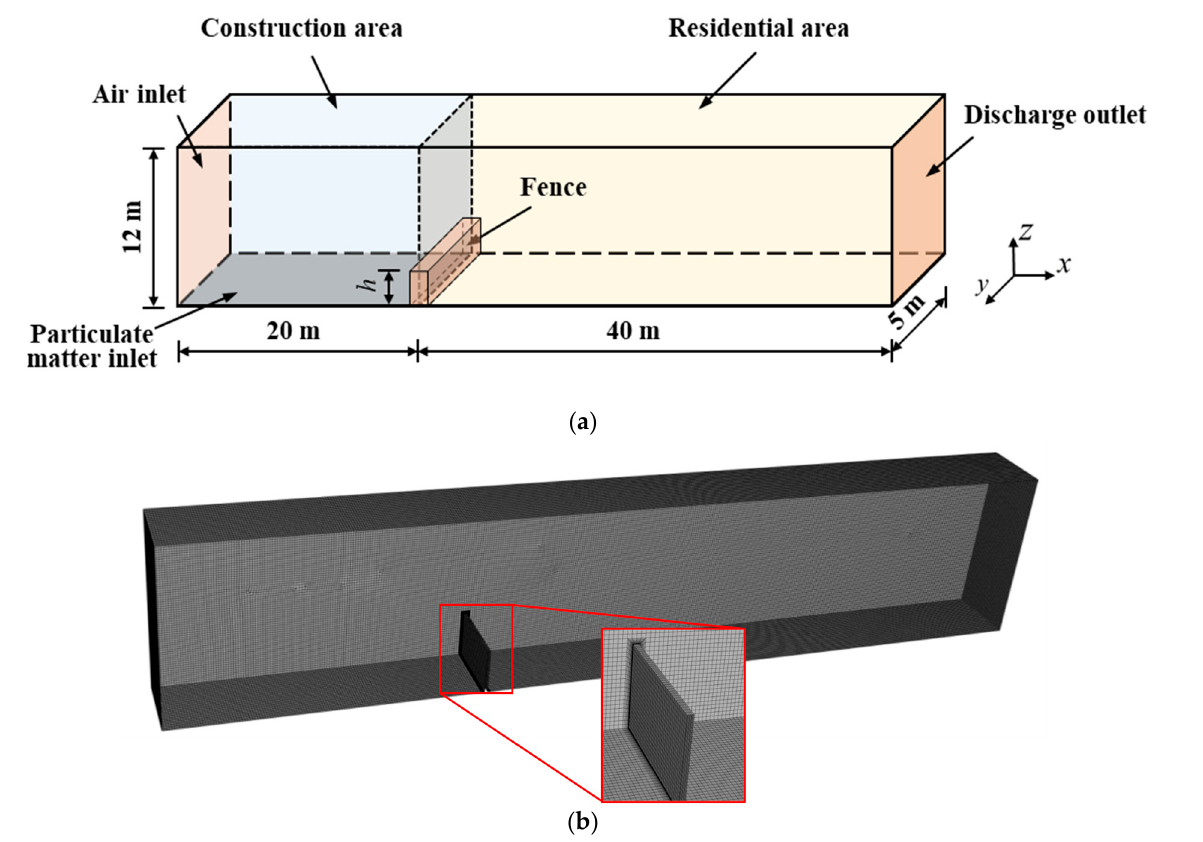
Figure 1. Numerical model of NPSD. ( a ) Numerical simulation model of diffusion behavior of NPSD. ( b ) Meshing effect on the numerical model.